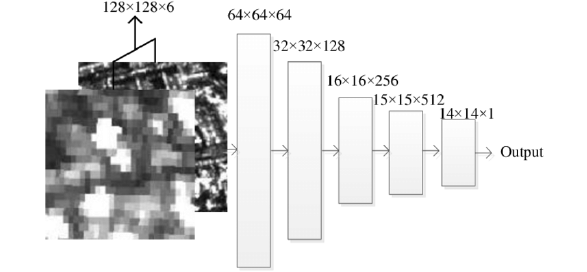
Figure 6. GANs-UNet discriminator function’s architecture from (Ao et al.,